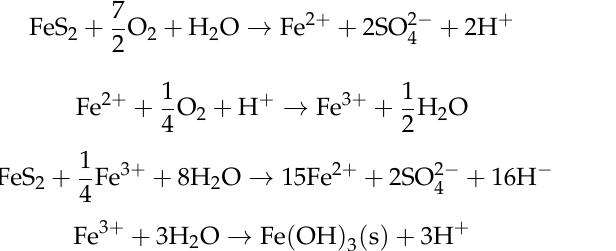
Sample Points Water/Water